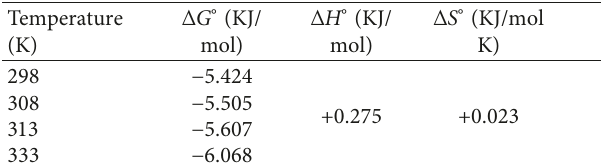
Table 6: One-, two-, and three-isotherm parameters for the ad- sorption of Co(II) on